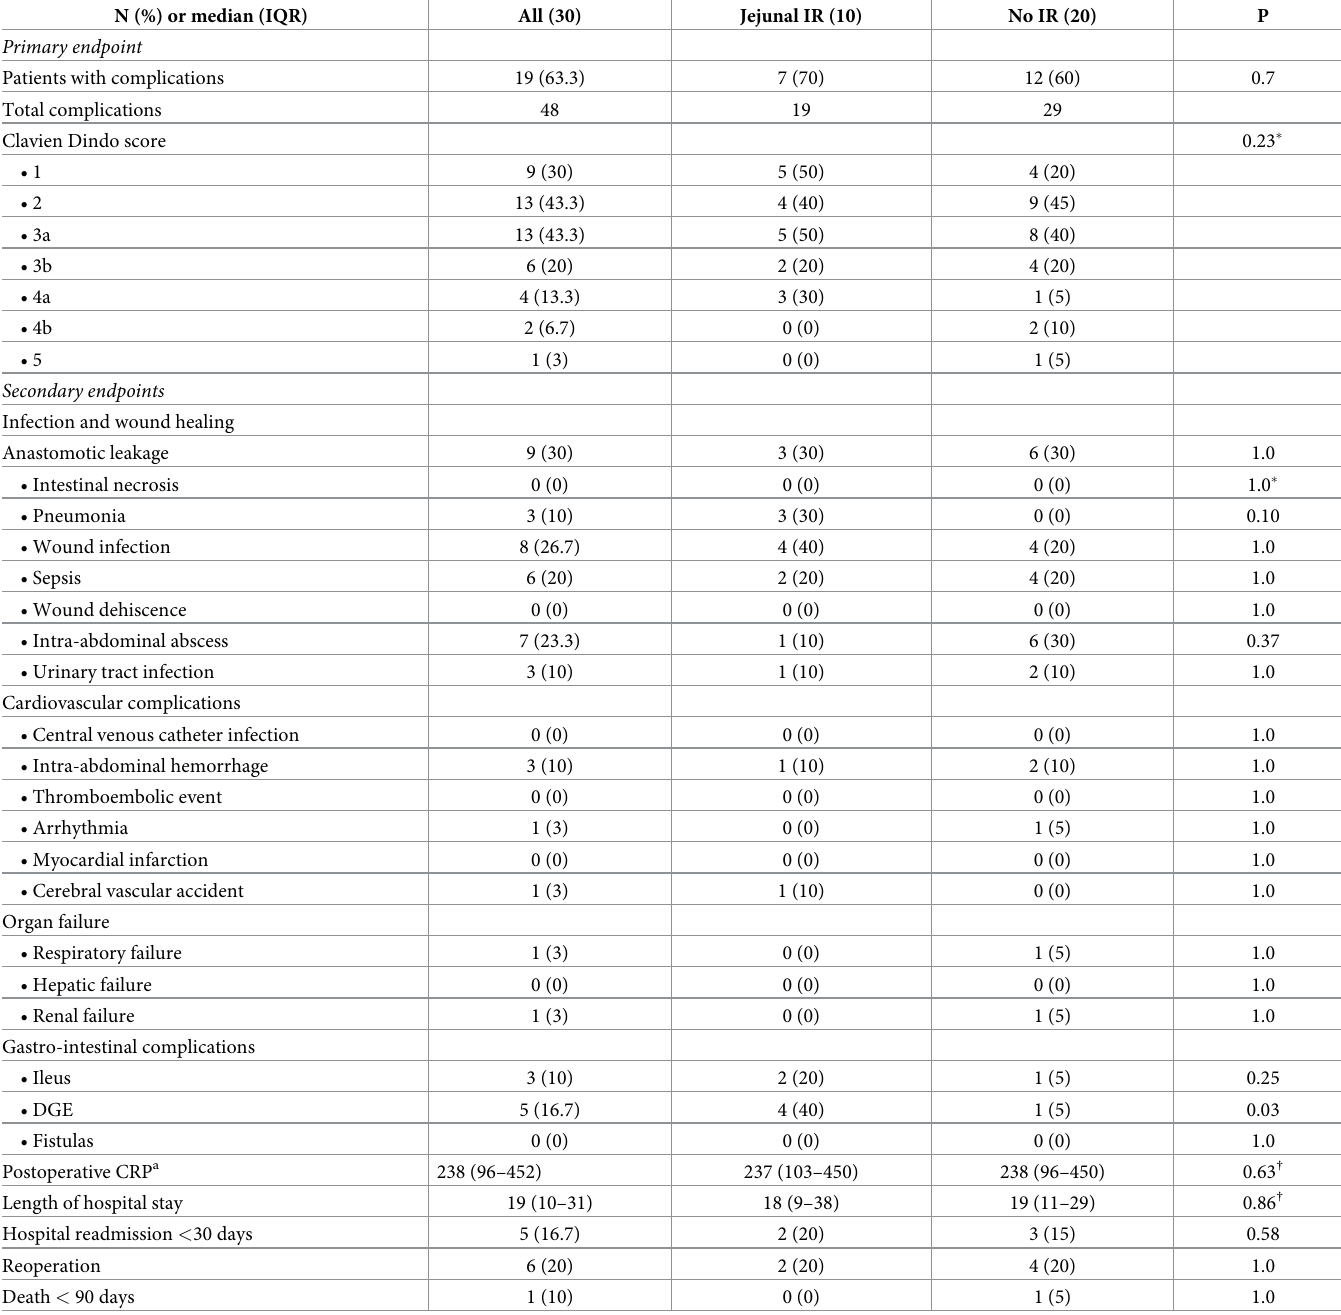
Table 3. Morbidity and mortality of patients undergoing pancreatic surgery with and without experimental in vivo jejunal IR. N (%) or median